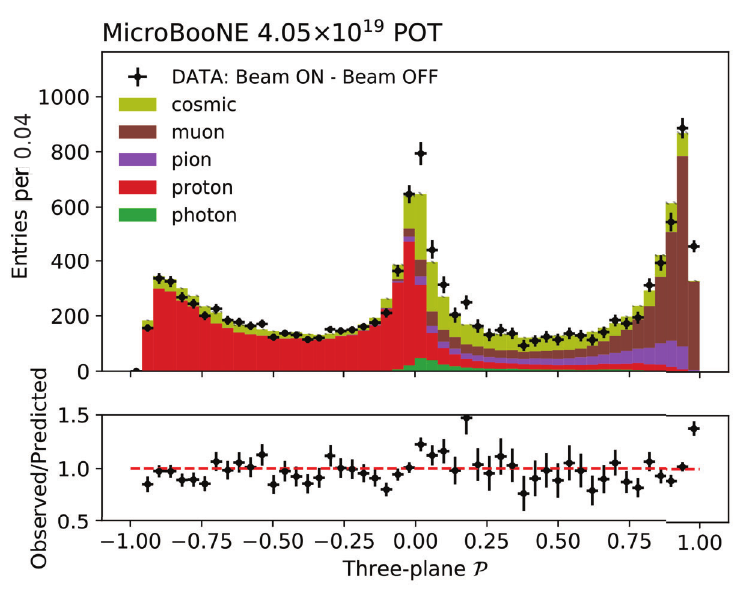
Figure 6. Distribution of the three-plane P for neutrino-induced tracks selected in data and simulation. The data (black cross) shows the difference between the DATA Beam ON and the DATA Beam OFF, in order to remove the contribution from non-beam events. The simulation (stacked histogram) is normalized to the same number of events observed in the data, and it is broken down for different particle species. In the case the particle selected in the simulation is an overlaid cosmic, it is assigned to the category “cosmic”. The uncertainties shown on the data points are the expected statistical uncertainties from Poisson counting. Figure 7. Collection-plane d E/ d x vs residual range profile for well reconstructed, contained, and low local pitch tracks in data, identified as muon (proton) candidates on the left (right) plot. The profiles are compared to the most probable values (MPV) as expected by the theory for the extremes of the range of local pitch under consideration (red lines). The two plots are normalized to the maximum value in order to share a common color